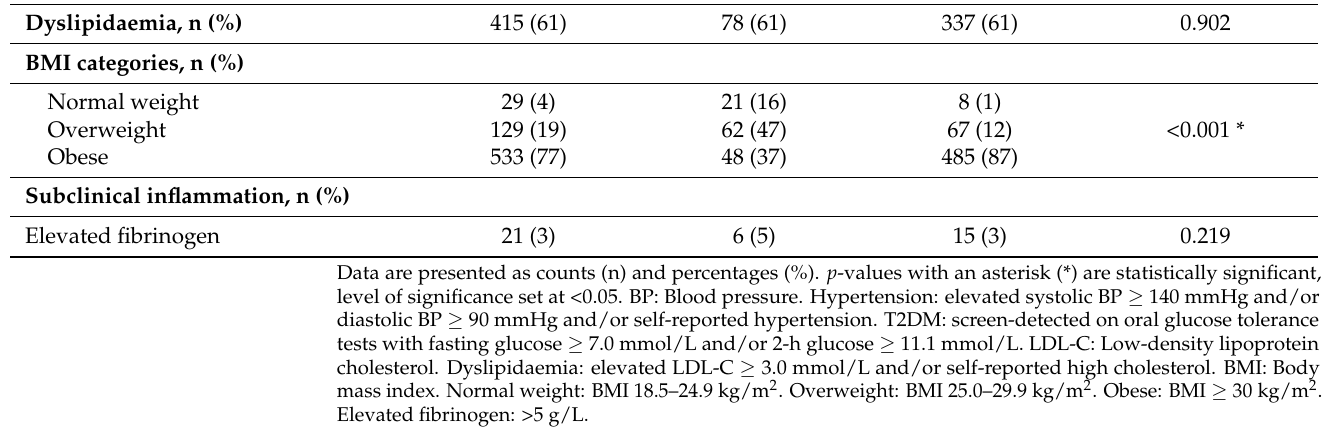
Table 5. OR and AORs with 95% CIs for CVD risk factors across plant food